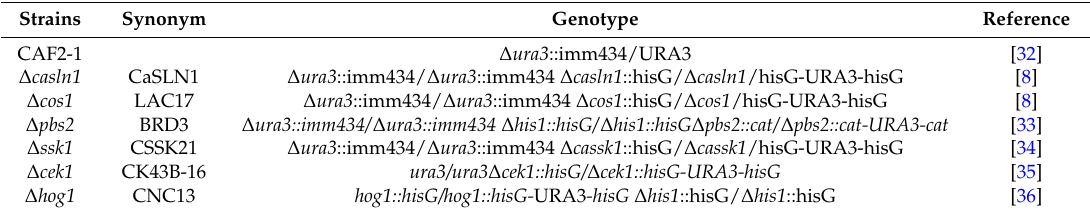
Table 1. C. albicans strains used in this